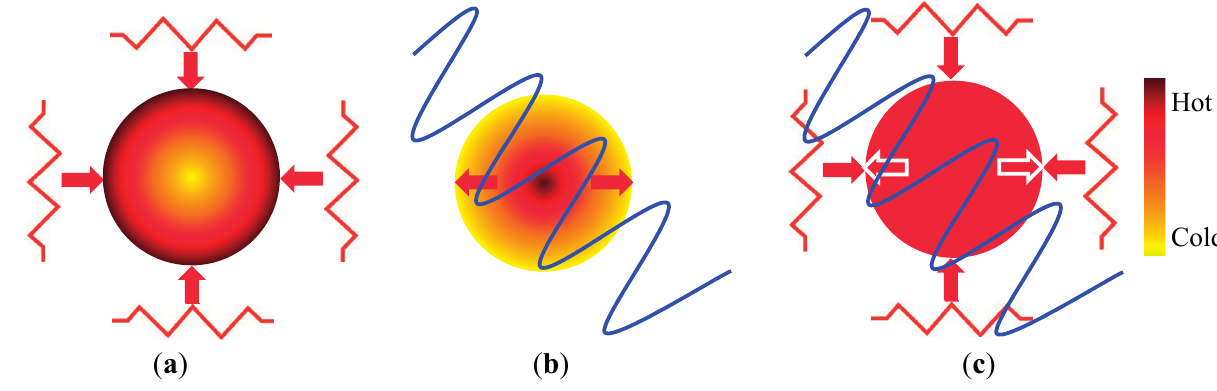
Figure 1. Heat distribution in an object during ( a ) conventional resistance heating, ( b ) microwave heating, and ( c ) hybrid heating using microwaves and radiant